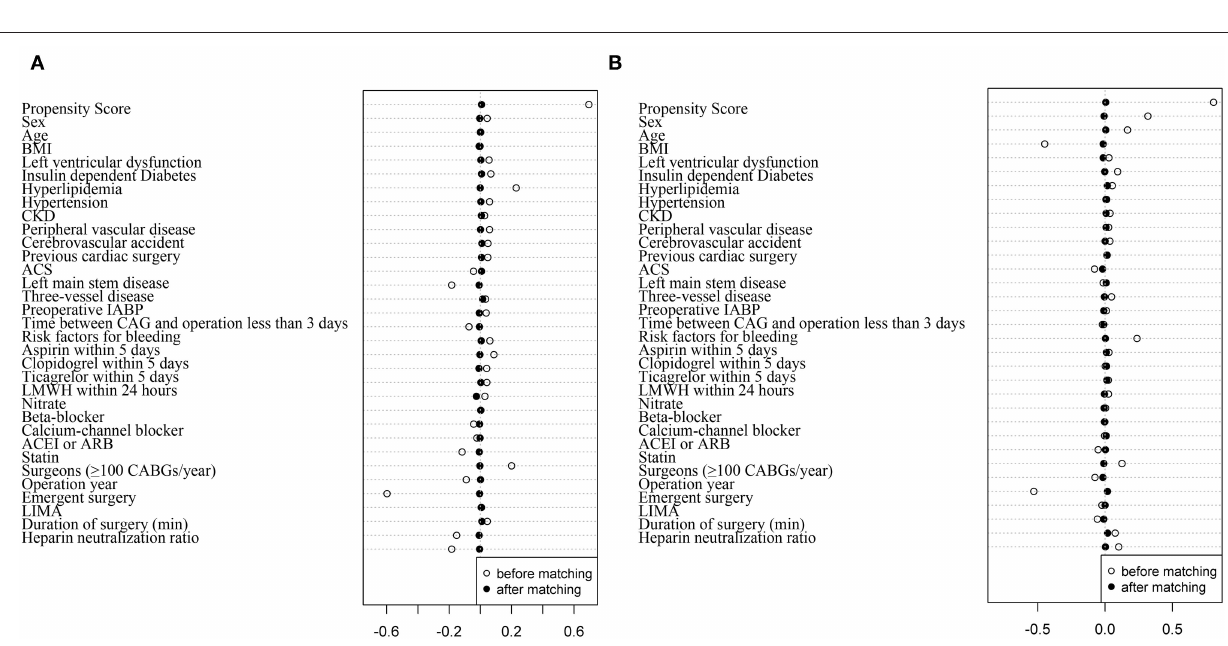
Frontiers in Cardiovascular Medicine |